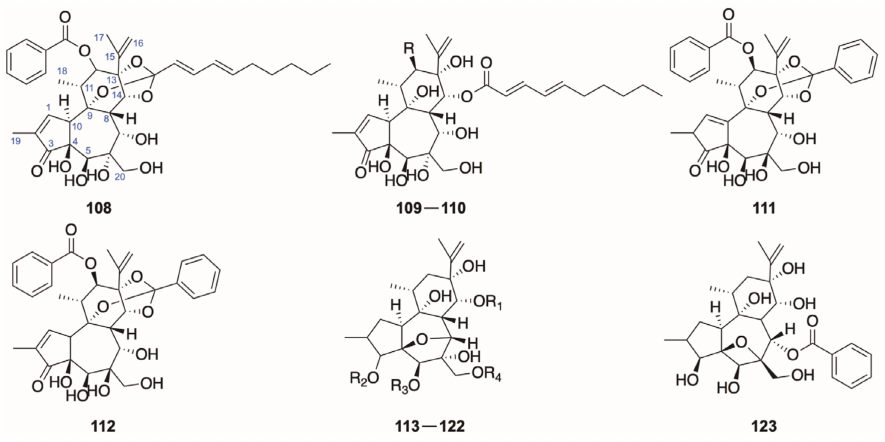
Figure 7. Structures of other daphnane diterpenoids from the genus Daphne ( 108 – 123